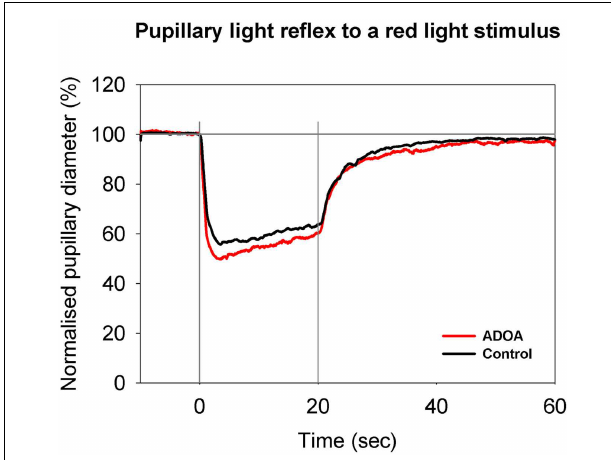
FIGURE 2 | Pupillary contraction to a blue light stimulus (470nm) as a function of time (s) .Time period, stimulus luminance, and size of input pupil as in Figure 1 .The light blue graph represents the mean of pupillary contractions set off by stimulation of the ADOA eyes, and the black graph the mean of contractions set off by stimulation in control eyes. In comparison with the graphs in Figure 1 , contraction is larger during light on in both graphs, and post-light stimulus re-dilatation far slower than that due to red light. After light termination, the difference between the two graphs is negligible. Results represent mean values from 29 subjects suffering from ADOA and from 40 healthy